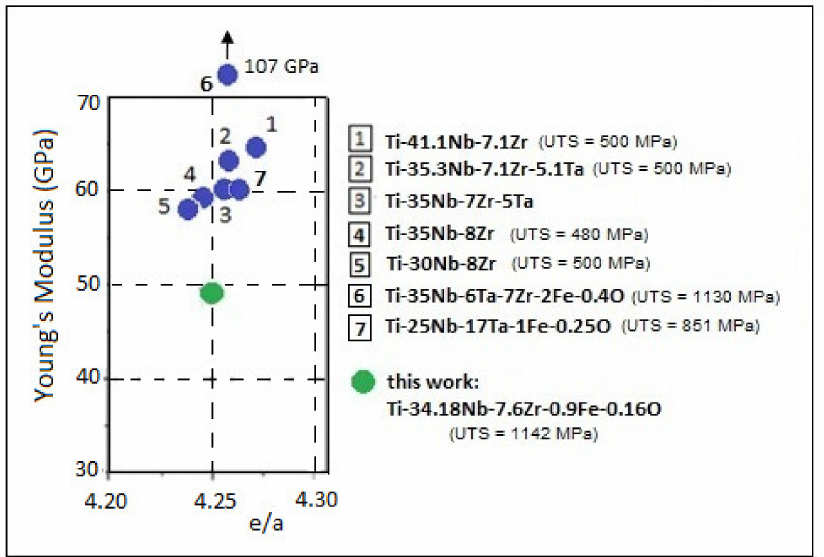
Figure 10. The Young’s modulus of the studied alloy compared to that of other similar β -Ti alloys. Alloy (1) from [70]; Alloy (2) from [24]; Alloy (3) from [71]; Alloy (4) and (5) from [43]; Alloy (6) from [11]; Alloy (7) from